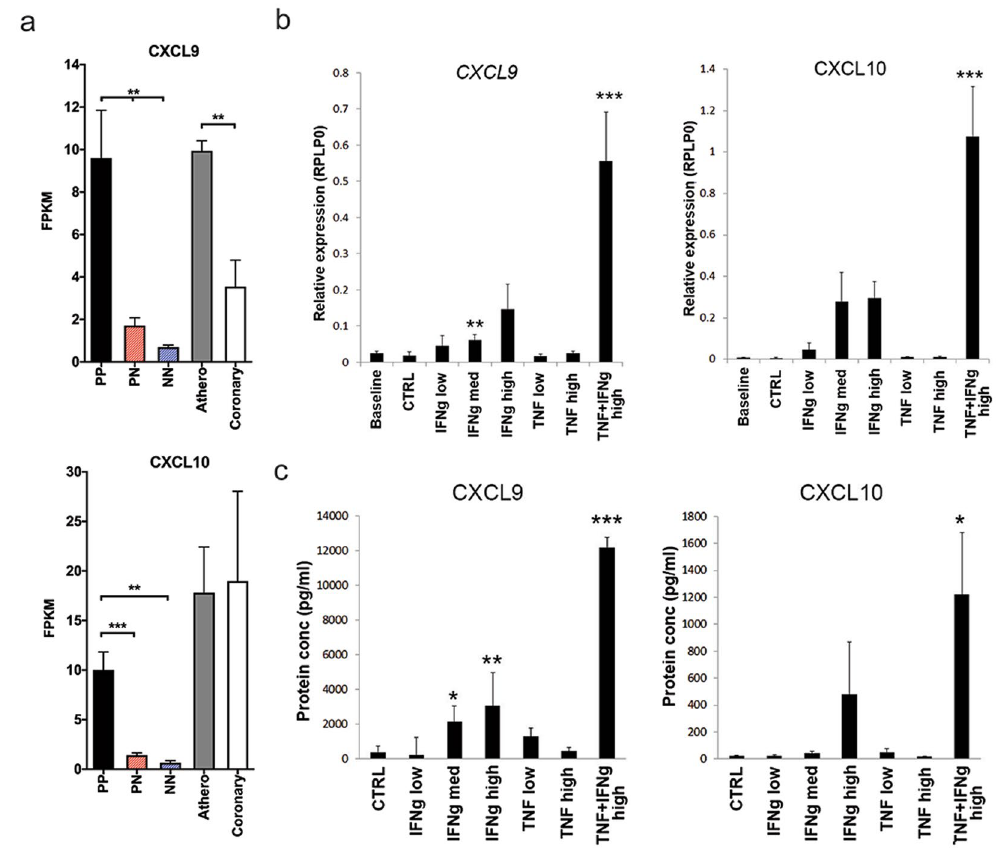
Figure 4. IFN- γ and TNF- α have synergistic activity on human atherosclerotic tissue ex vivo . ( a ) CXCL9 and CXCL10 mRNA expression in lesional (PP), non-lesional (PN) and healthy skin (NN), atherosclerotic (athero), healthy vascular tissue (coronary) obtained through RNA-sequencing and shown as FPKM values. ( b , c ) Atherosclerotic arterial tissue obtained post-amputation was dissected into 3 mm slices and stimulated with a high or low dose of IFN- γ or TNF- α or a combination of both for 6 hours for ( b ) mRNA expression or 72 hours for ( c ) protein secretion 6 . Dose-dependent increases in the mRNA expression and protein secretion of CXCL9 and CXCL10 were observed with IFN- γ (0.5, 5 and 50 ng/ml), whereas minimal change in expression was seen with TNF- α stimulation (1 ng/ml or and 10 ng/ml). In contrast, a striking synergistic effect was seen with IFN- γ and TNF- α stimulation (IFN- γ 50 ng/ml, TNF- α at 10 ng/ml). Data are shown as mean ± SEM with 95%